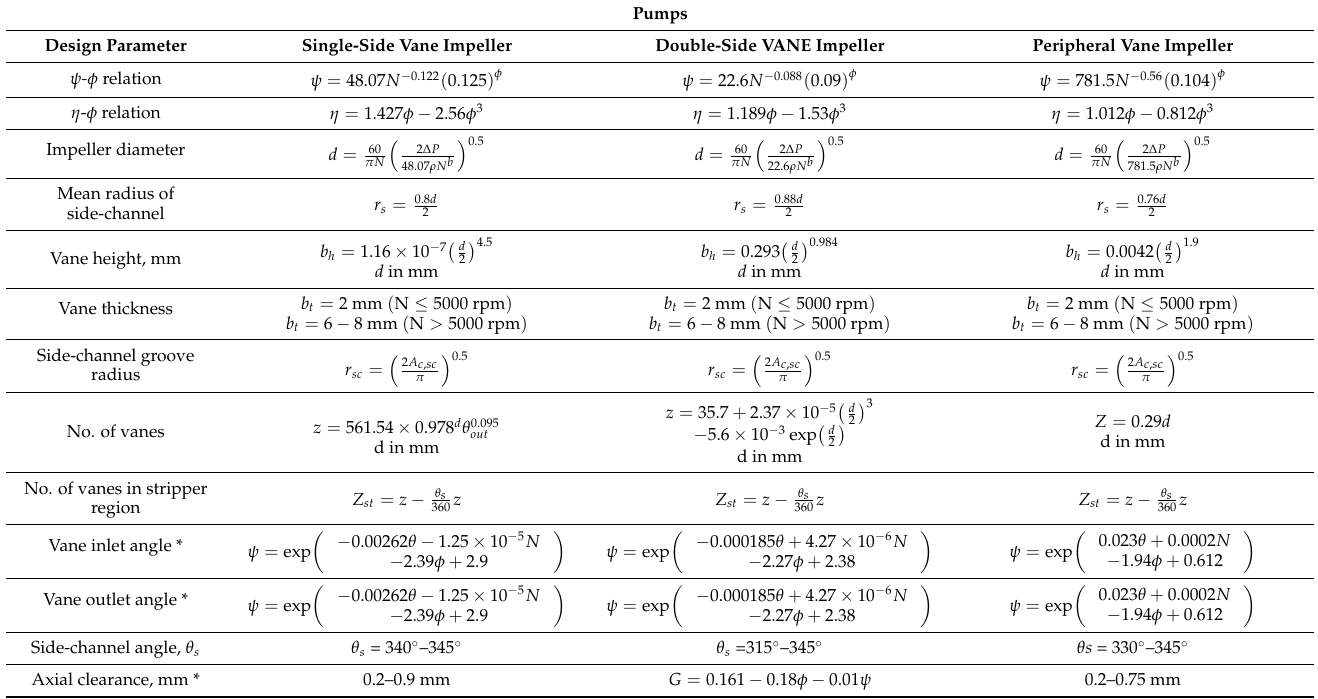
Table 1. Consolidated Table of Correlations for Regenerative Flow Pump design.